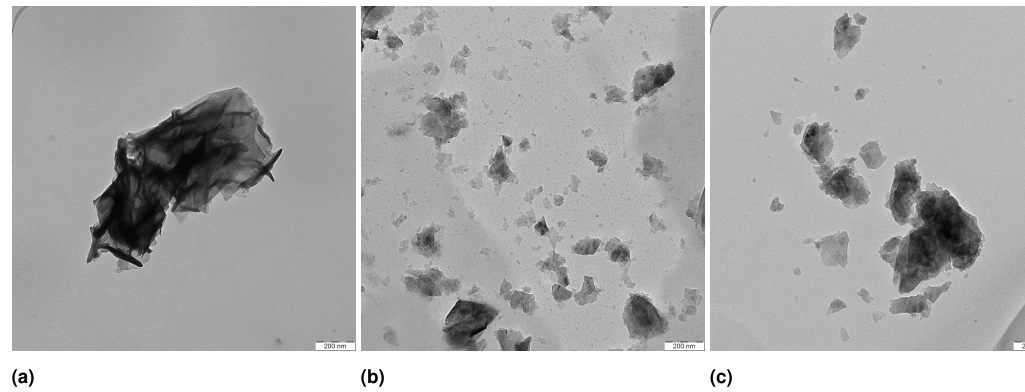
Fig. 4. TEM images of NiO nps (a) pH 8, (b) pH 9 and (c) pH 10.